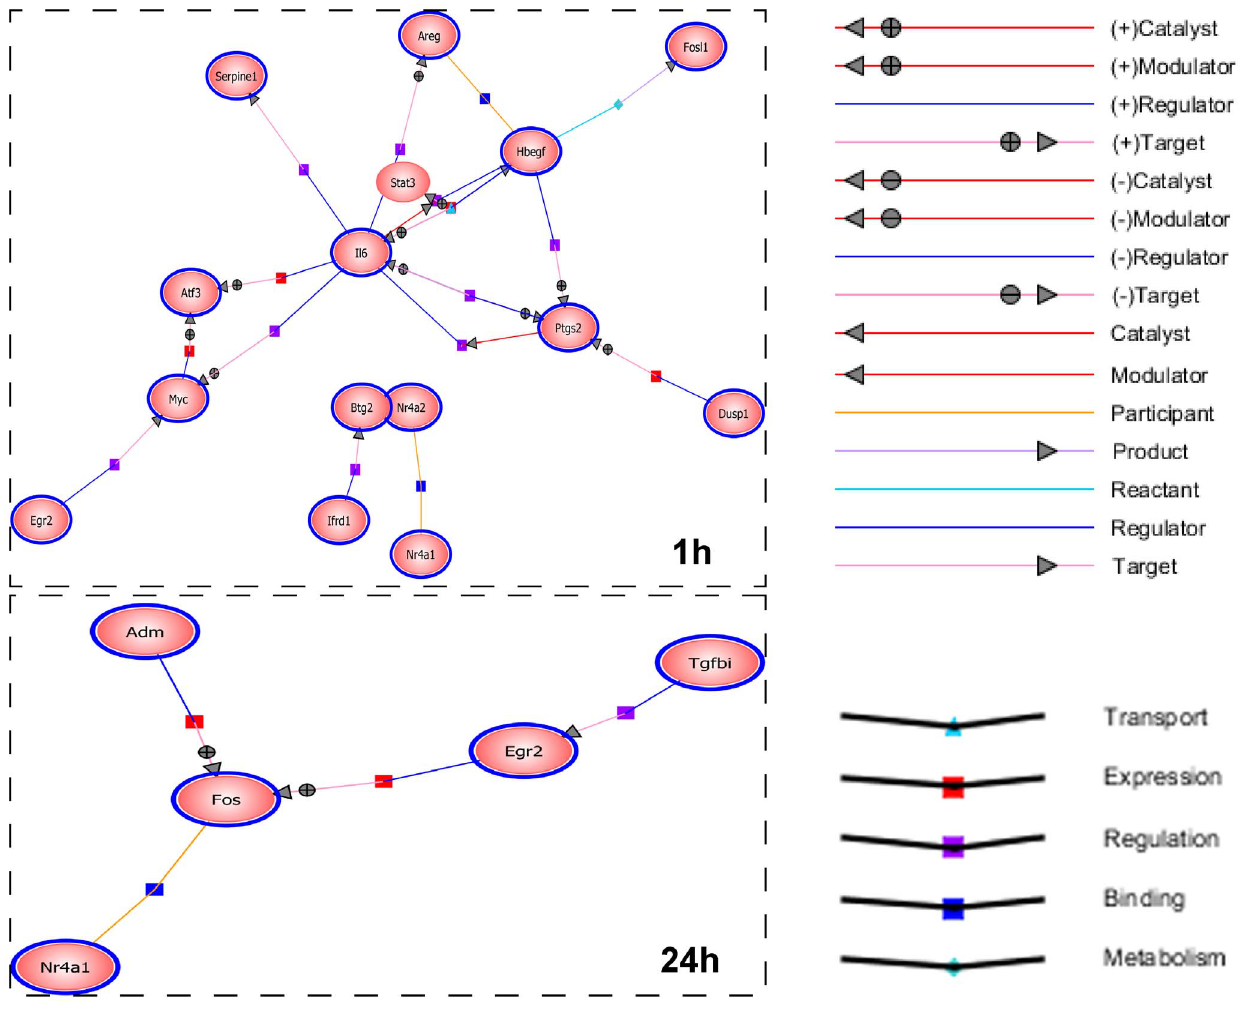
Figure 3. Interaction networks of gene products induced by mechanical stretching at 1 and 24 h. This diagram, prepared using Gene Spring Software, illustrates the known direct interactions between the proteins encoded by 56 genes at 1 h and 62 genes at 24 h (p , 0.05, more than twofold change). IL 6, Hbegf, Ptgs2, and Myc at 1 h and Fos at 24 h show strong interaction centers. Ovals surrounded by blue lines represent proteins included in the above